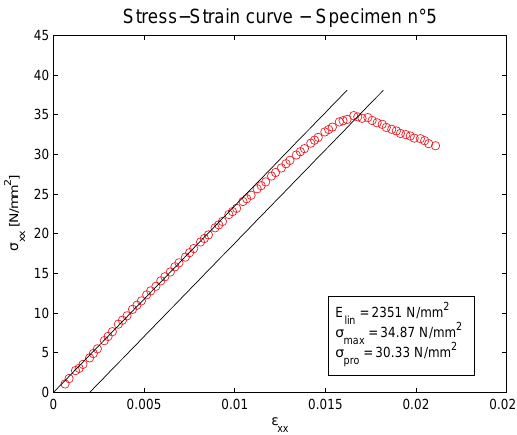
Figure 13: Actual stress-strain curve for specimen 3.